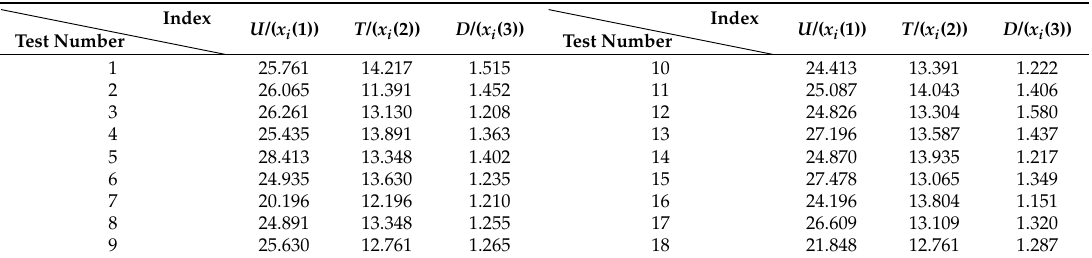
Table 8. Simulative results of the orthogonal test of the combined progress.